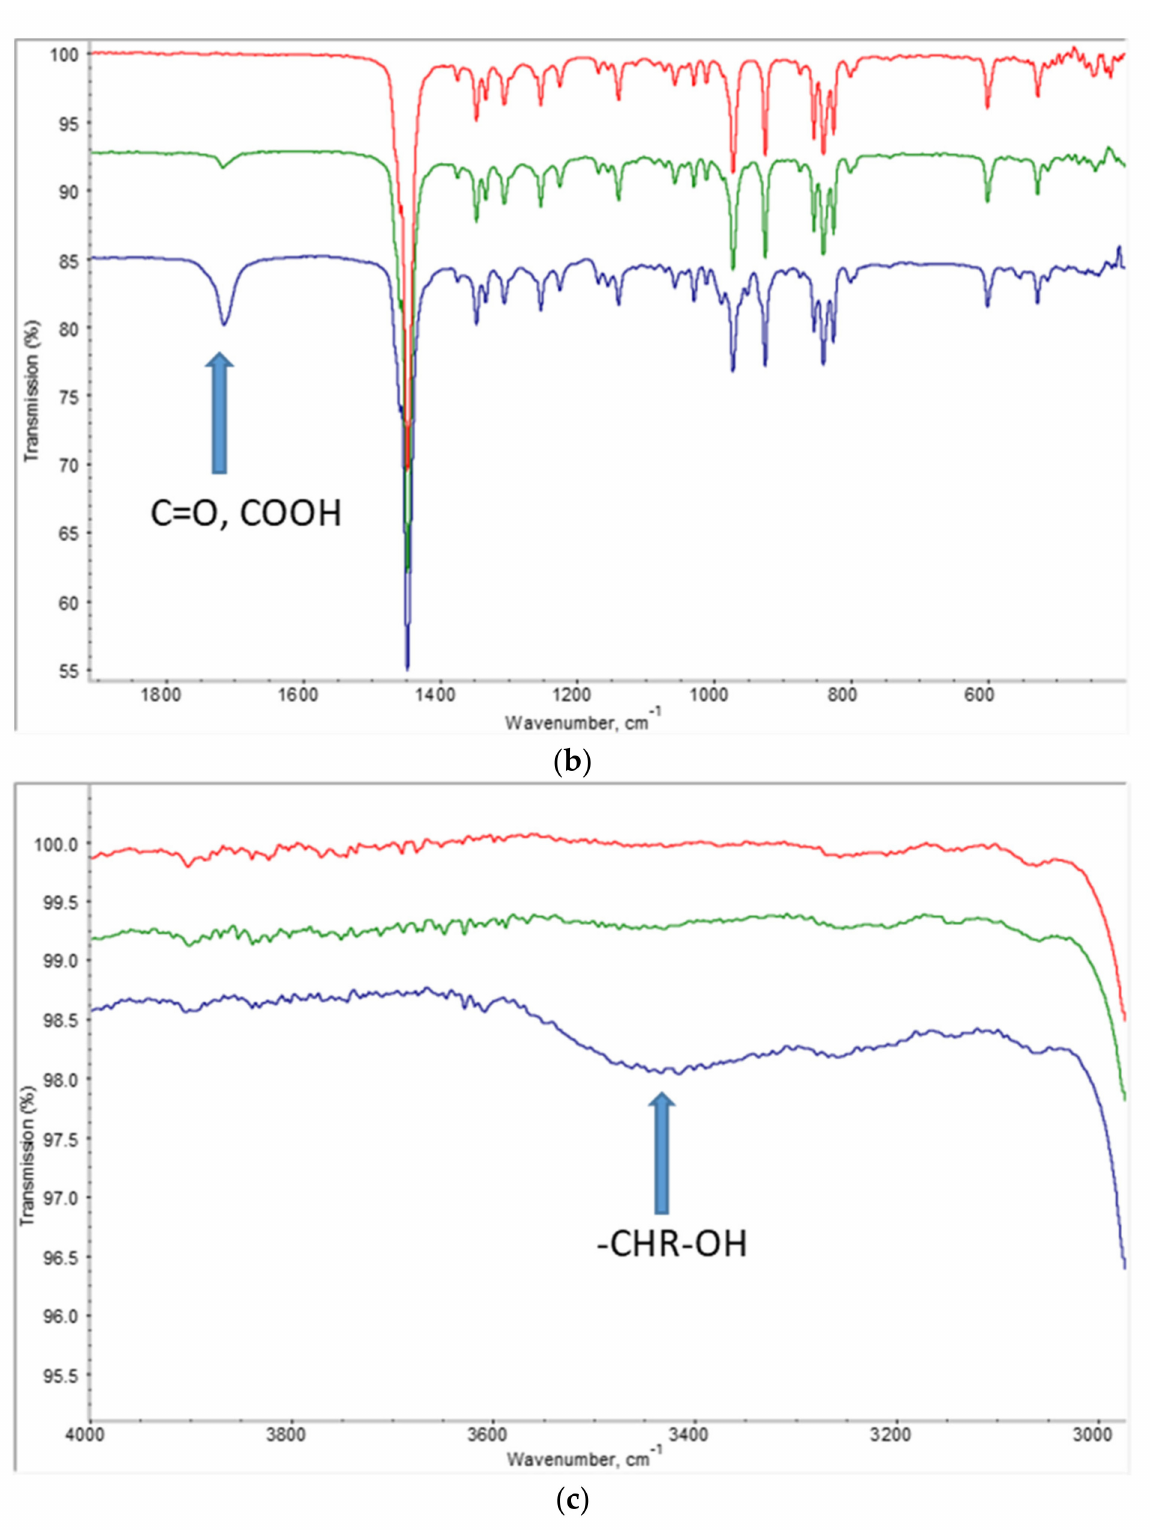
Figure 6. IR-ATR spectra of the initial mixture of cis and trans-decalins (red), and the same mixture after ozonation for 15 min (green) and 70 min (blue): ( a ) survey spectra in the entire frequency range; ( b ) spectra in the region of 2000–400 cm − 1 ; ( c ) spectra in the region of 4000–2900 cm − 1 . An increase in the ozonolysis reaction time to 70 min led to a significant increase in the intensity of the absorption bands at 3450 cm − 1 and 1717 cm − 1 . At the same time,